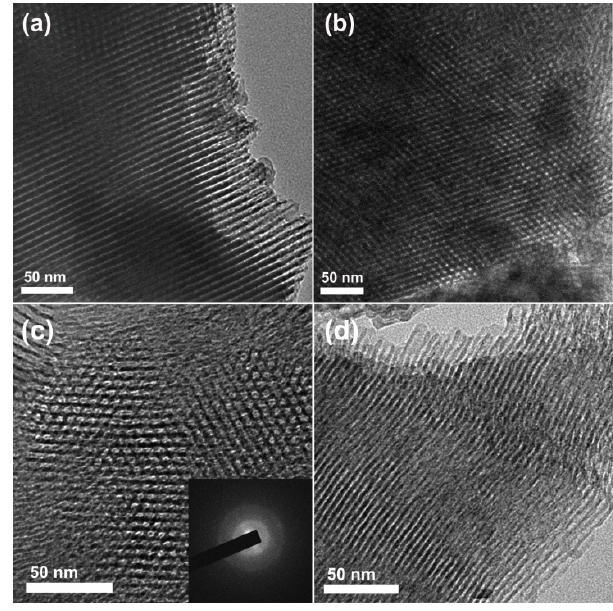
Figure 3. Transmission electron microscopy (TEM) images of sample OMZA-6 viewed along the (110) ( a ) and (100) ( b ) directions, TEM image ( c ) of OMZA-6 thermally treated at 1000 °C for 1 h, and TEM image ( d ) of OMZA-6 hydrothermally treated at 100 °C for 6 h, respectively.